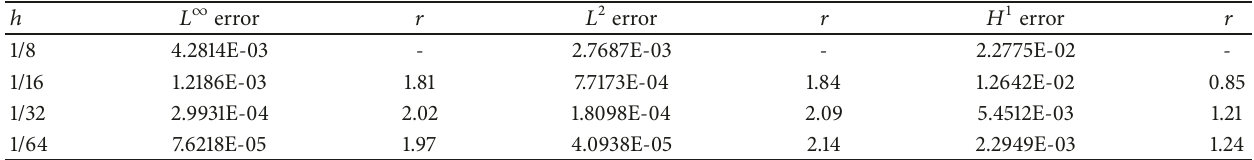
Table 4: Errors of the control for different error norms.